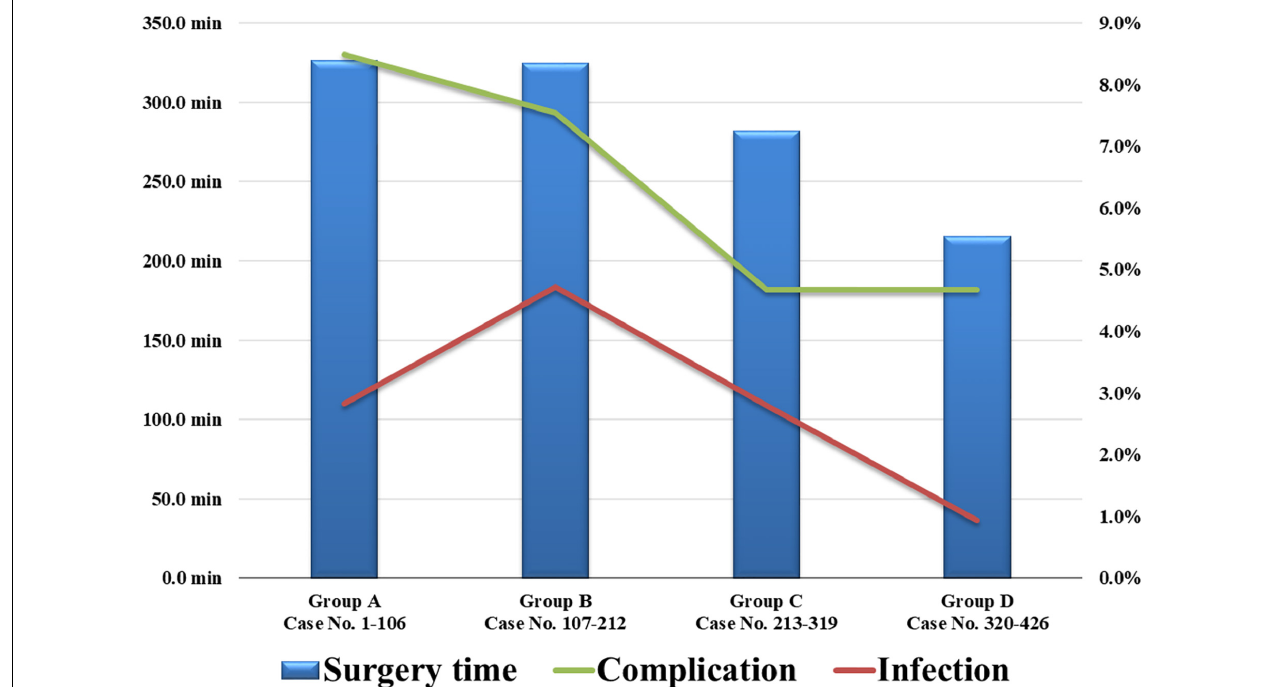
FIGURE 5 | The 426 cases of bilateral DBS surgery were divided into four chronological groups based on their operation date. The recent average operation time and complications and infections rates were reduced. DBS, deep brain stimulation.